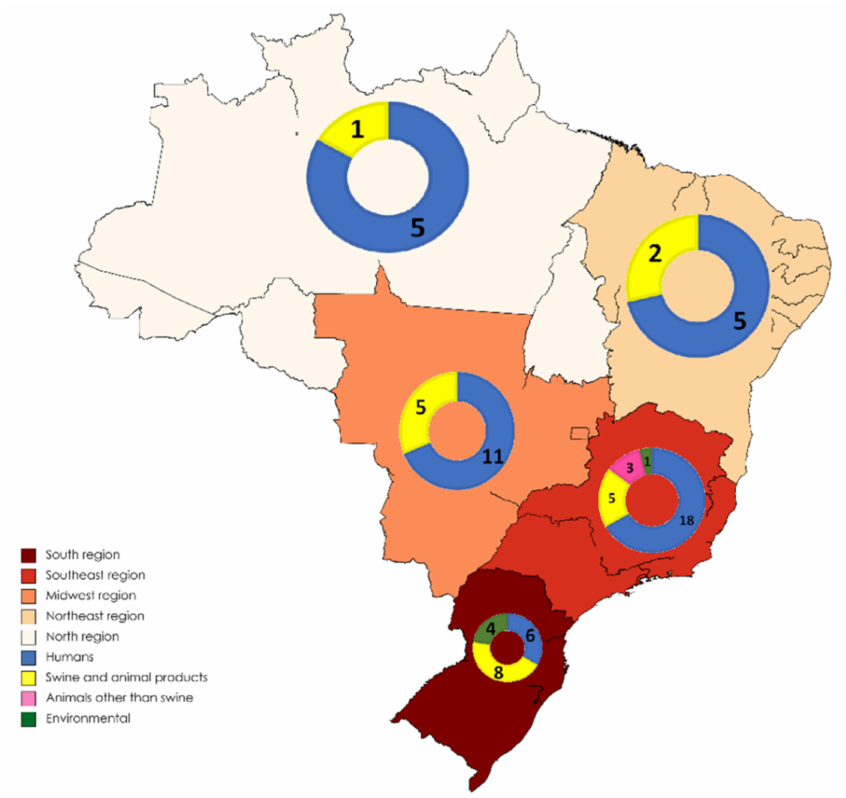
Figure 2. Distribution (number) of HEV studies according to the regions of Brazil and the origin (human, swine and animal products, animals other than swine, and